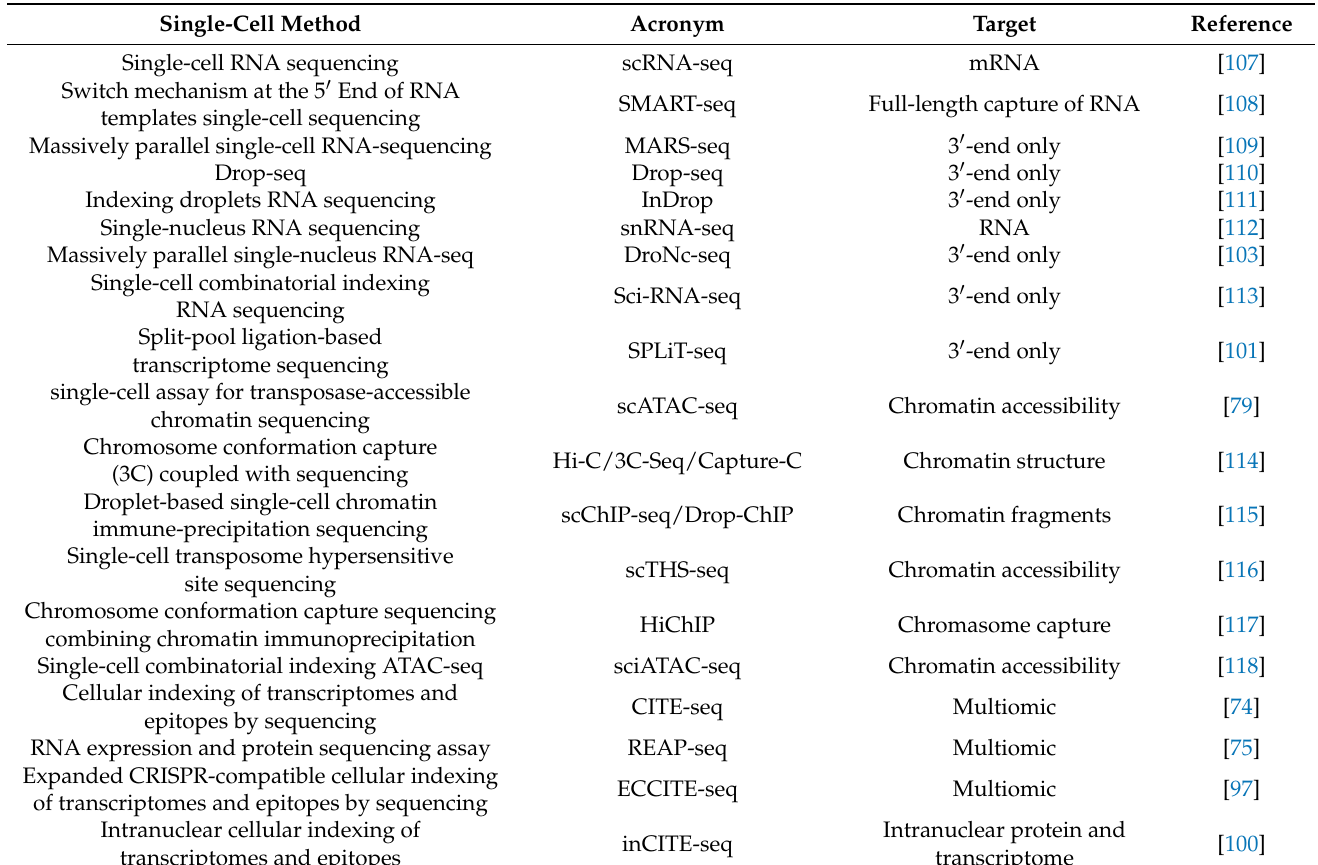
Table 2. Single-cell